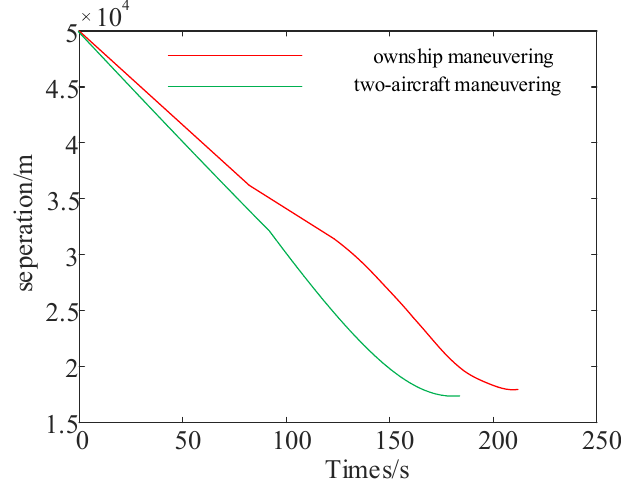
Figure 12. Separation-time diagram of own ship separation assurance strategy.